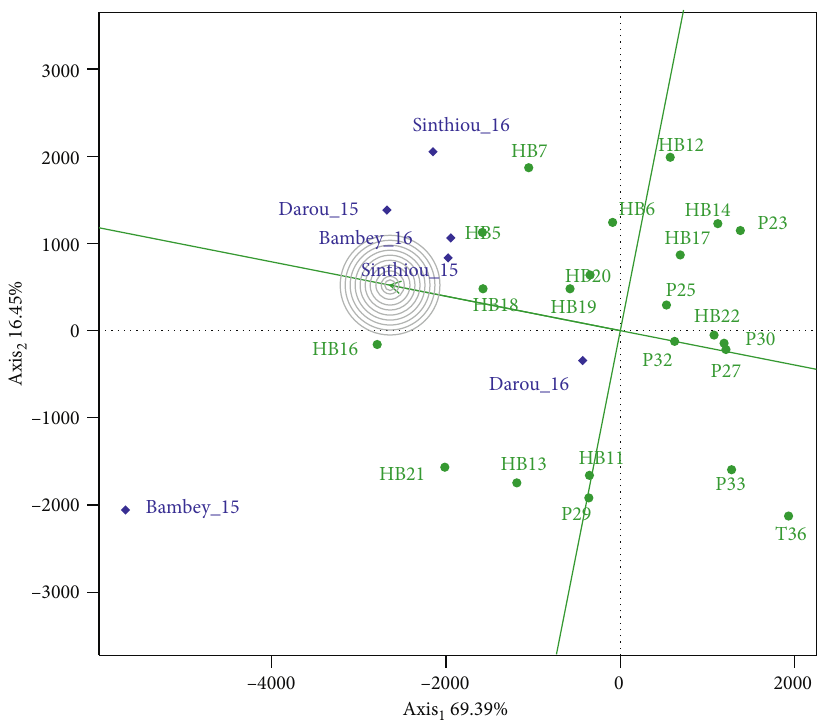
Figure 6: Ranking genotypes for grain yield based on both mean performance and stability with reference to an “ideal” genotype. The green single-arrowed horizontal line represents the AEC abscissa, and the green vertical line represents the AEC ordinate. The AEC abscissa arrowhead indicates where an “ideal” genotype should be. Its projection on the AEA was designed to be equal to the longest vector of all genotypes, and its projection on the AEC was obviously zero, meaning that it is absolutely stable. Genotypes located closer to the ideal genotype are more desirable than others. The concentric circles help to visualize the position of the genotype with respect to ideal genotype. Genotype and environment labels are represented in green and blue,